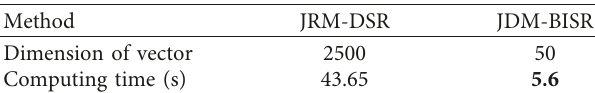
Table 6: Image deblurring results comparison in terms of SSIM. Method Table 7: The computing time of JRM-DSR and JDM-BISR methods. Method